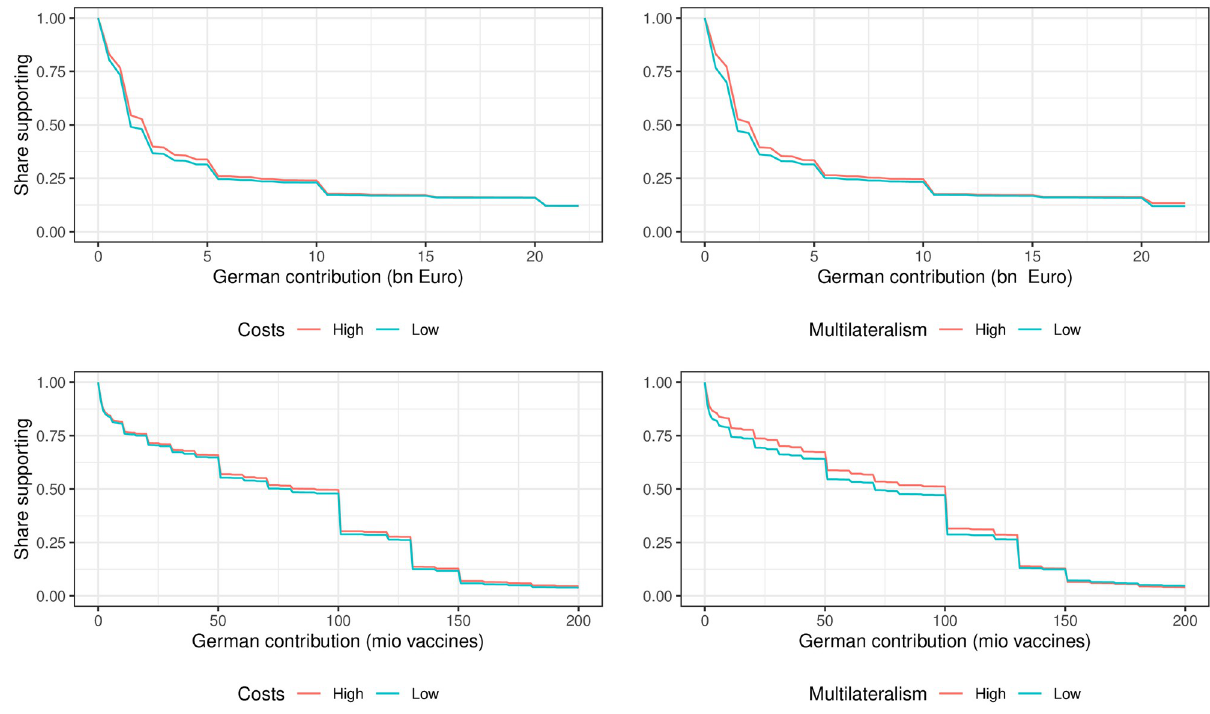
Fig 1. Distribution of support for contributions of different